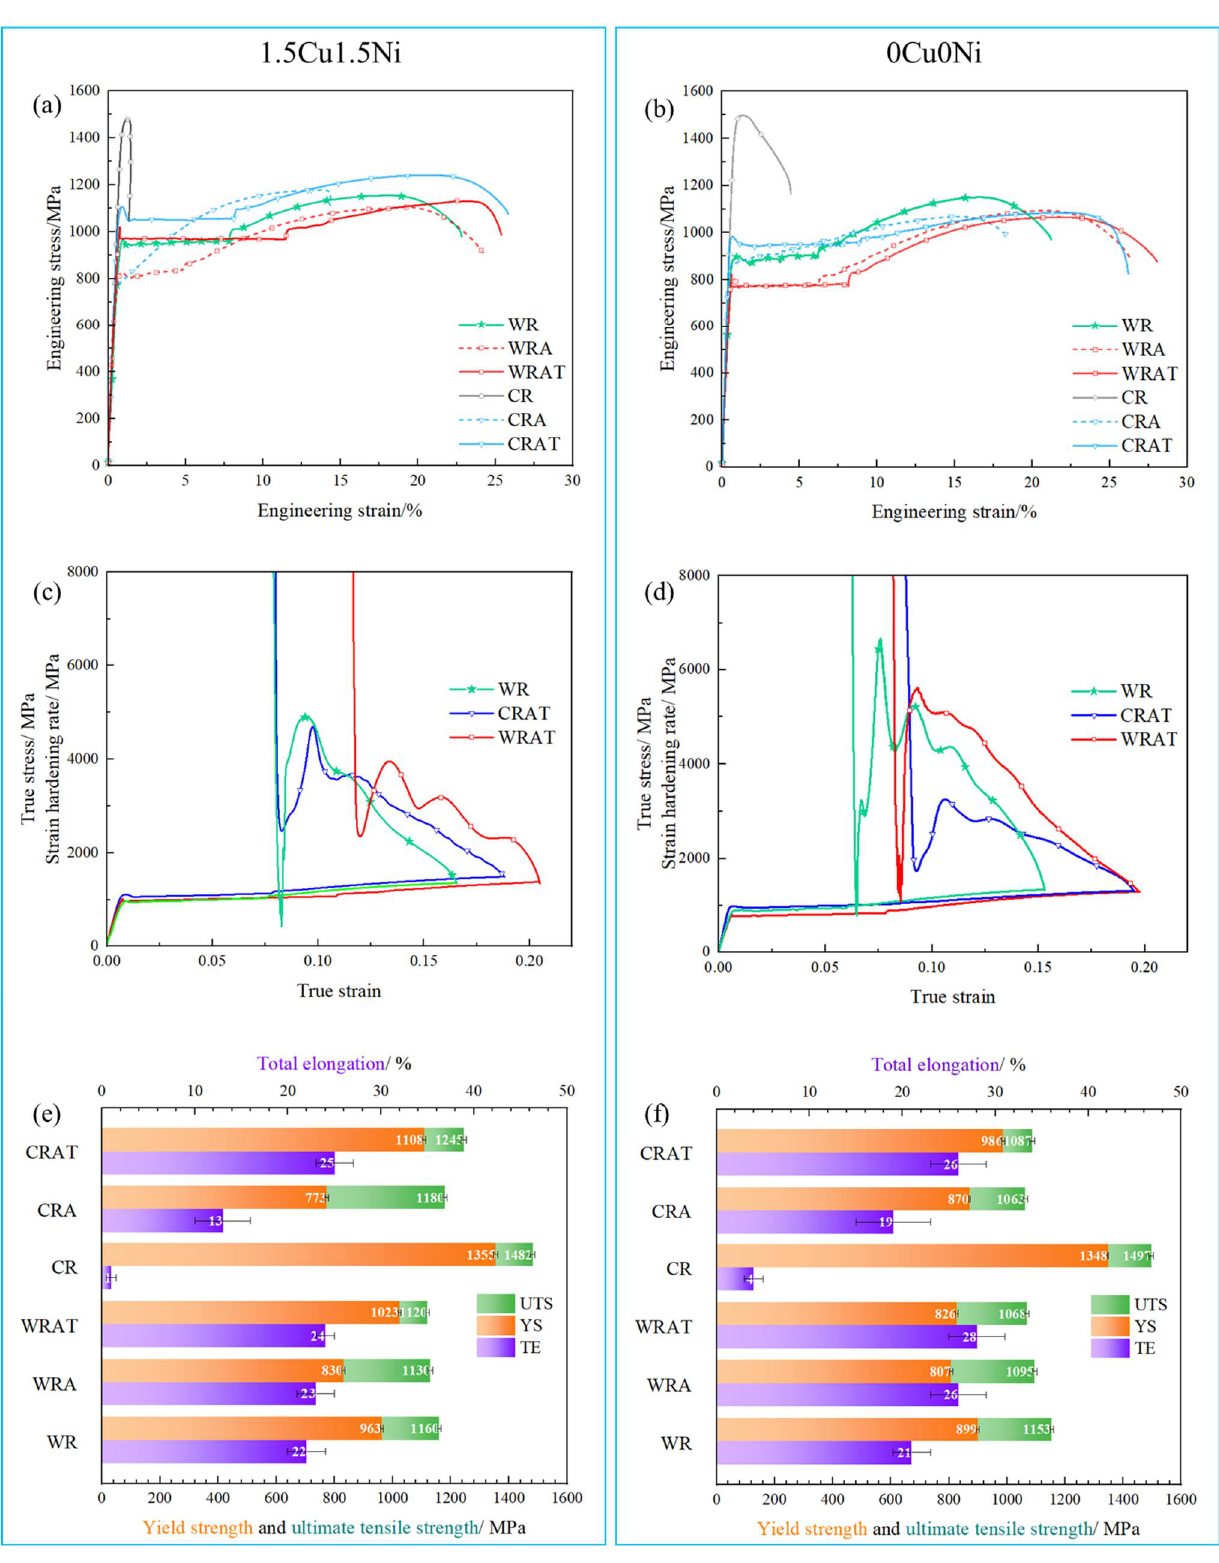
Figure 2. Uniaxial tensile tests of the investigated materials. ( a , b ) Engineering stress–strain curves, ( c , d ) true stress–strain curves, and ( e , f ) values of yield strength, ultimate tensile strength and total elongation of 1.5Cu1.5Ni and 0Cu0Ni alloys,